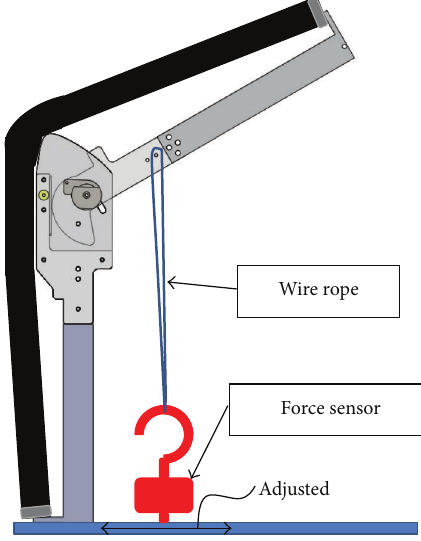
Figure 14: Setup for the torque measurement. mechanism with the hinge parts. The upper and lower cuffs fit on the legs during abduction and adduction of the knee.